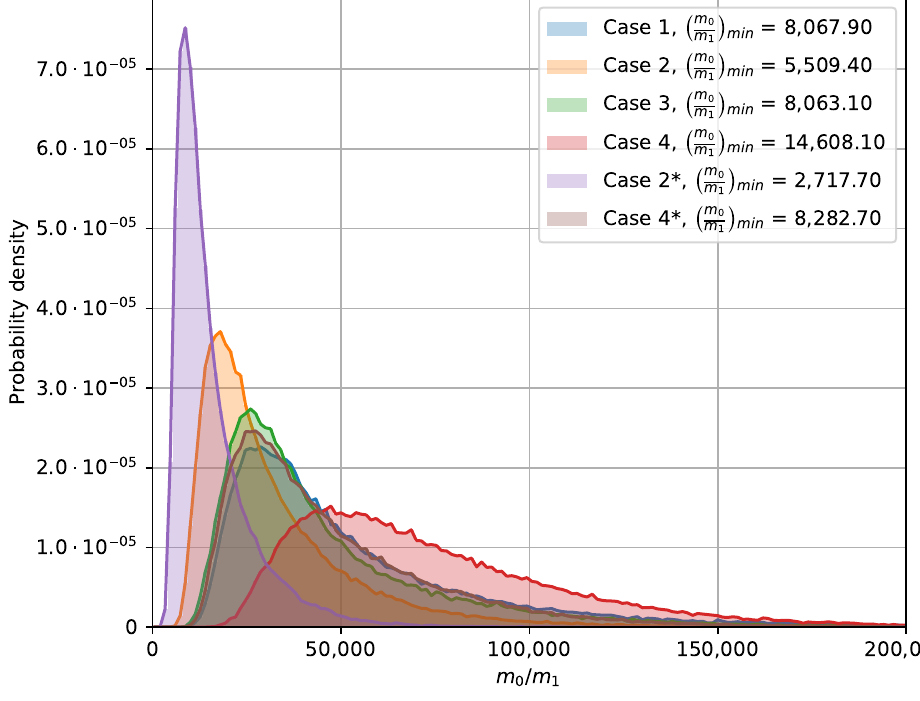
Figure 9. Dominant contribution factor ratio comparison.